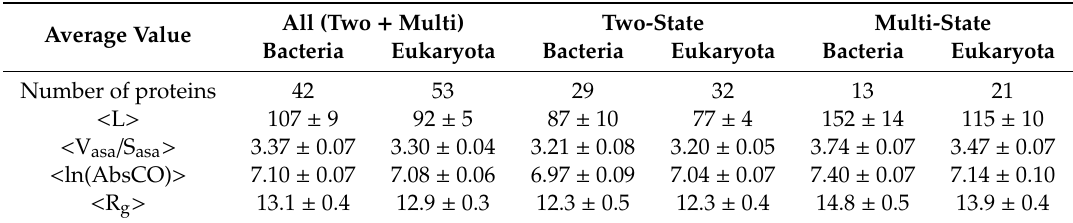
Figure 3. The average values of the logarithm of the unfolding and folding rates for bacterial and eukaryotic two- and multi-state proteins. Structural parameters that better correlate with the logarithm of the unfolding rate are outlined in a rectangle. Table 5. Average values of structural parameters for two-state and multi-state bacterial and eukaryotic proteins.